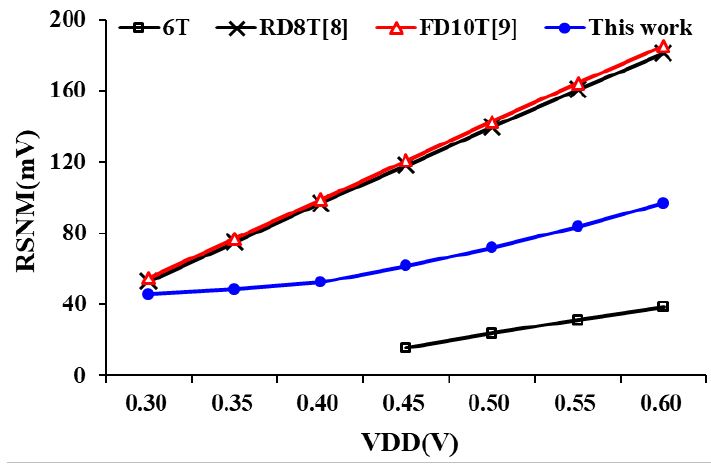
Figure 12. RSNM of bit-cell operates at different voltages.